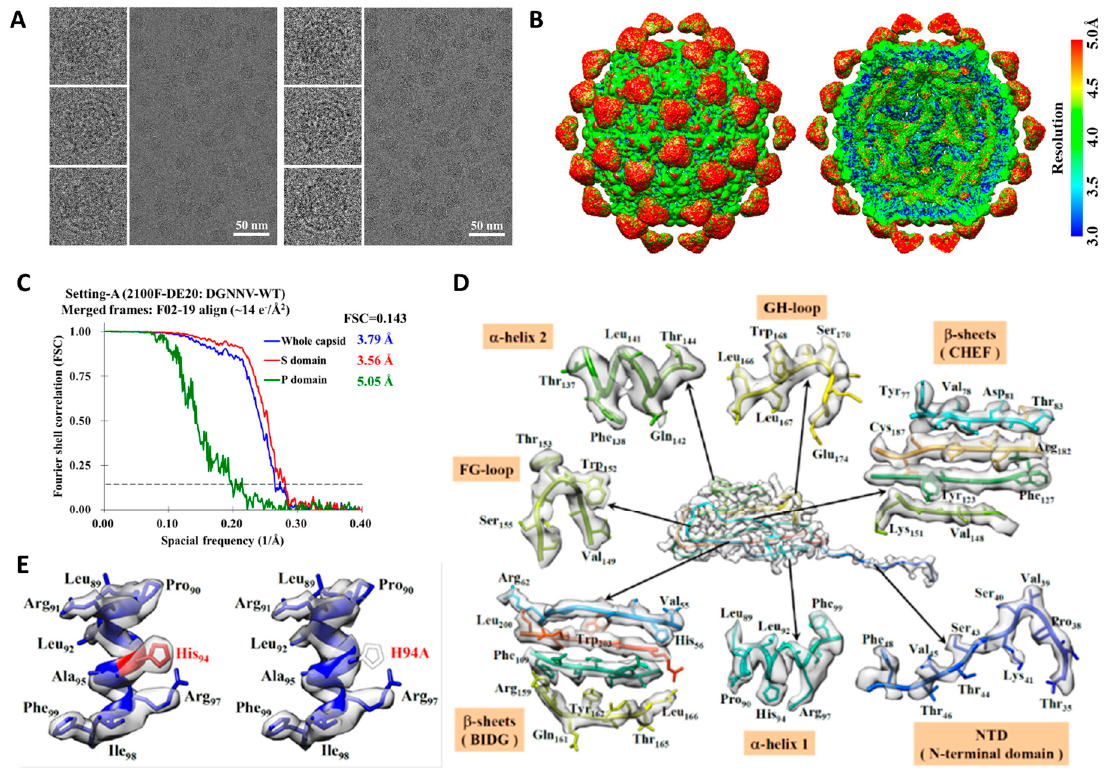
Figure 1. The cryo-EM structure of DGNNV particle from setting A. ( A ) The left is a representative raw micrograph and the right is after whole-micrograph motion correction. ( B ) Overall cryo-EM structure of DGNNV virus-like particle and the cutaway view to visualize the inside. The color spectrum indicates the estimated local resolutions. ( C ) The gold standard FSC curves show the overall resolutions of the whole capsid, the shell (S-domain) and the protrusion (P-domain). ( D ) The density maps of α -helices, β -sheets, and loops extracted from the S-domain of the capsid protein, displayed in the center. ( E ) Comparison of a local density map of wild DGNNV and that of the mutant of